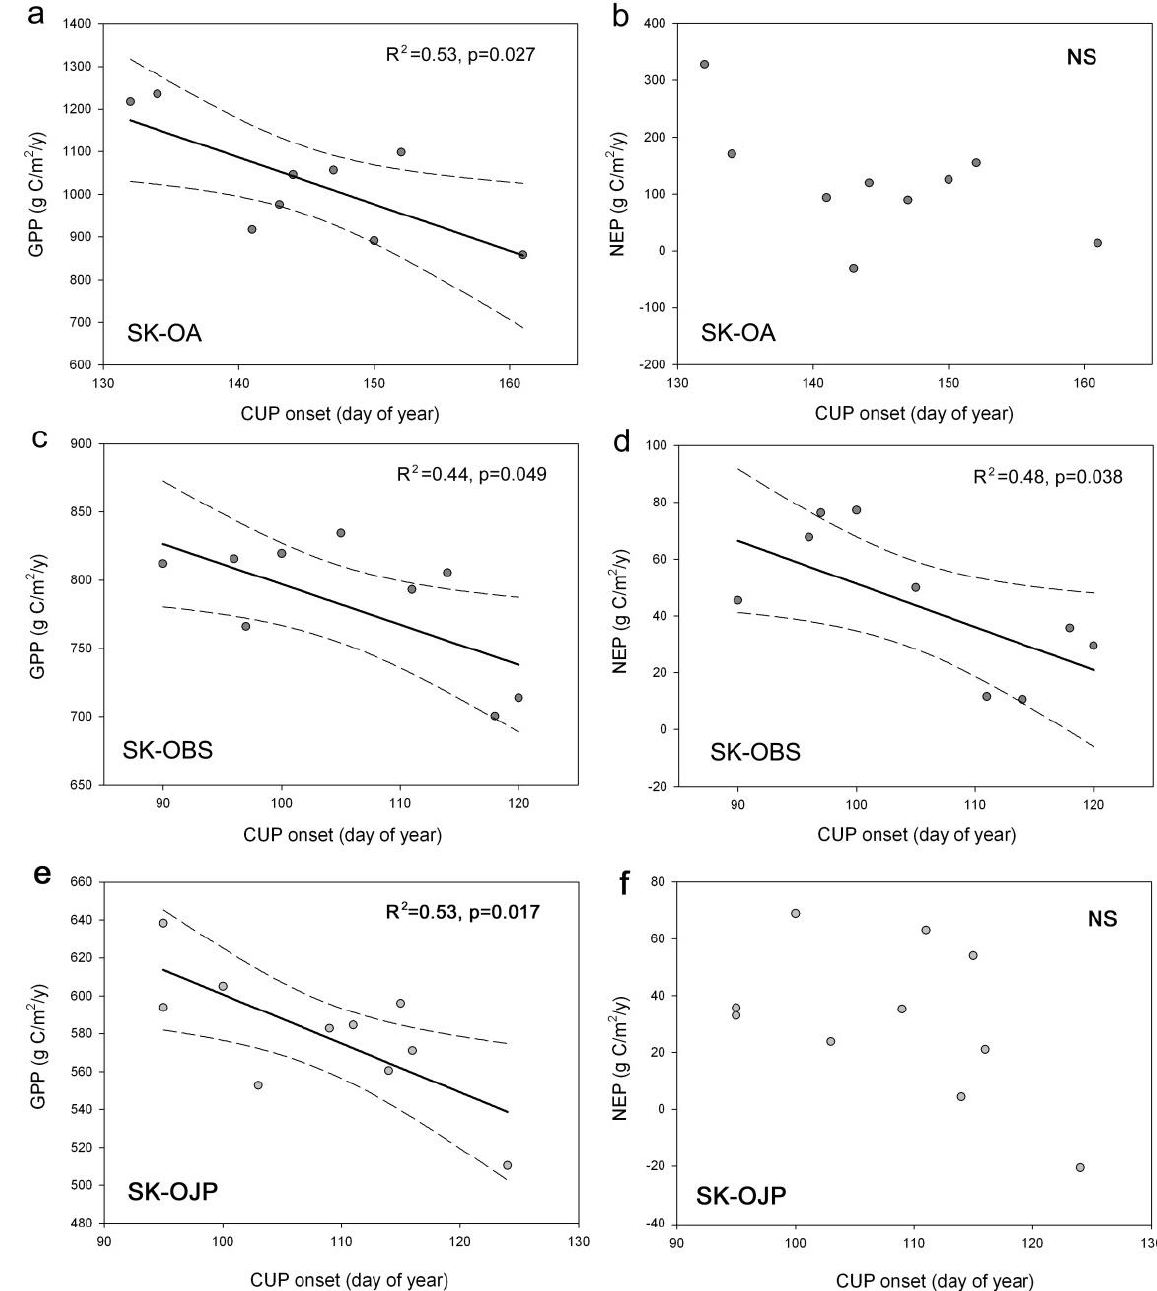
Figure 4. Relationships between the C-uptake period onset (CUP) and ( a ) GPP of SK-OA, ( b ) NEP of SK-OA, ( c ) GPP of SK-OBS, ( d ) NEP of SK-OBS, ( e ) GPP of SK-OJP, and ( f ) NEP of SK-OJP. NS indicates no significant correlation. The solid and dashed lines represent regression and its 95% confidence of mean